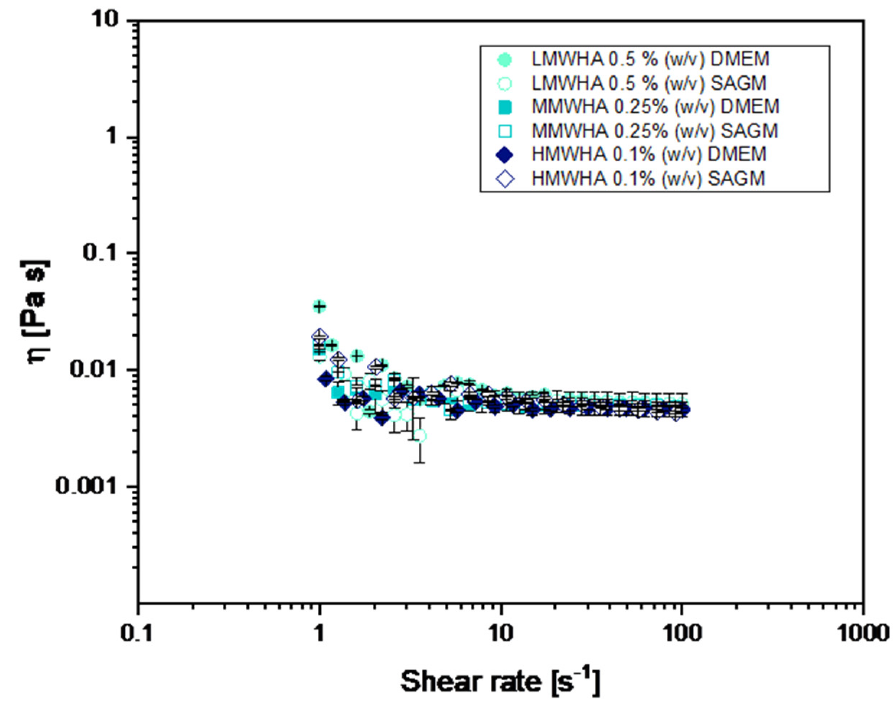
Figure 2. Steady shear tests. Viscosity as a function of shear rate for LMWHA, MMWHA, and HMWHA in DMEM and SAGM cell culture media. The viscosity decreases by increasing the shear rate (shear thinning behaviour).